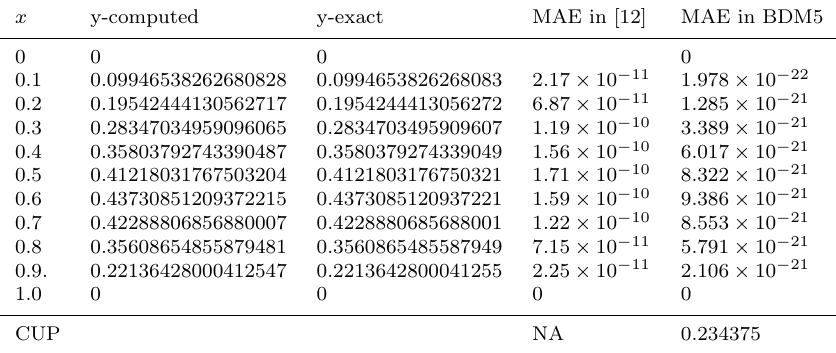
Table 2. Comparison of observed maximum absolute errors on Example 1 with h = 1 / 10.